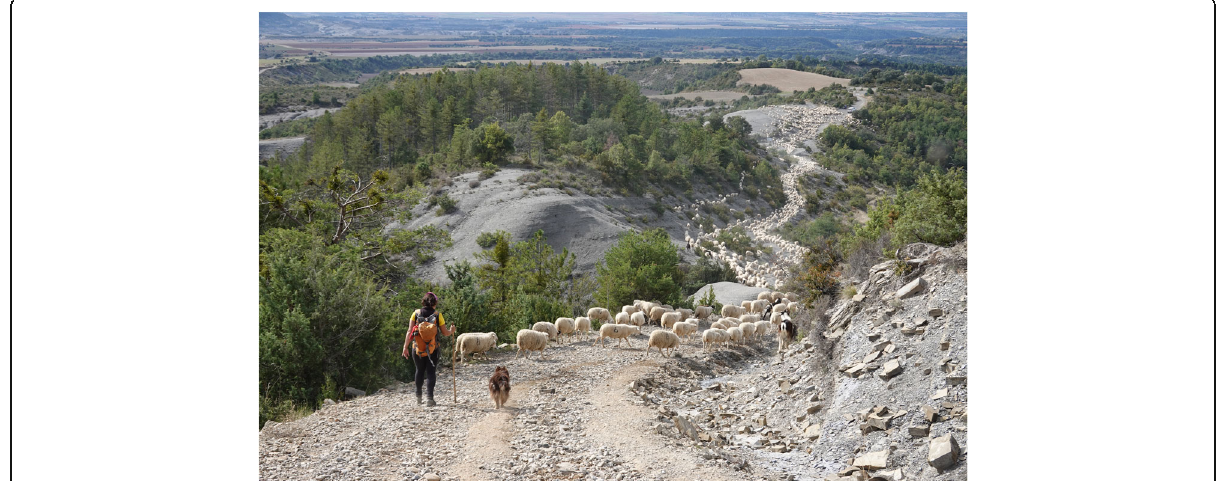
Fig. 4 Transhumant herd descending from the Pyrenees to winter grazing in Cinco